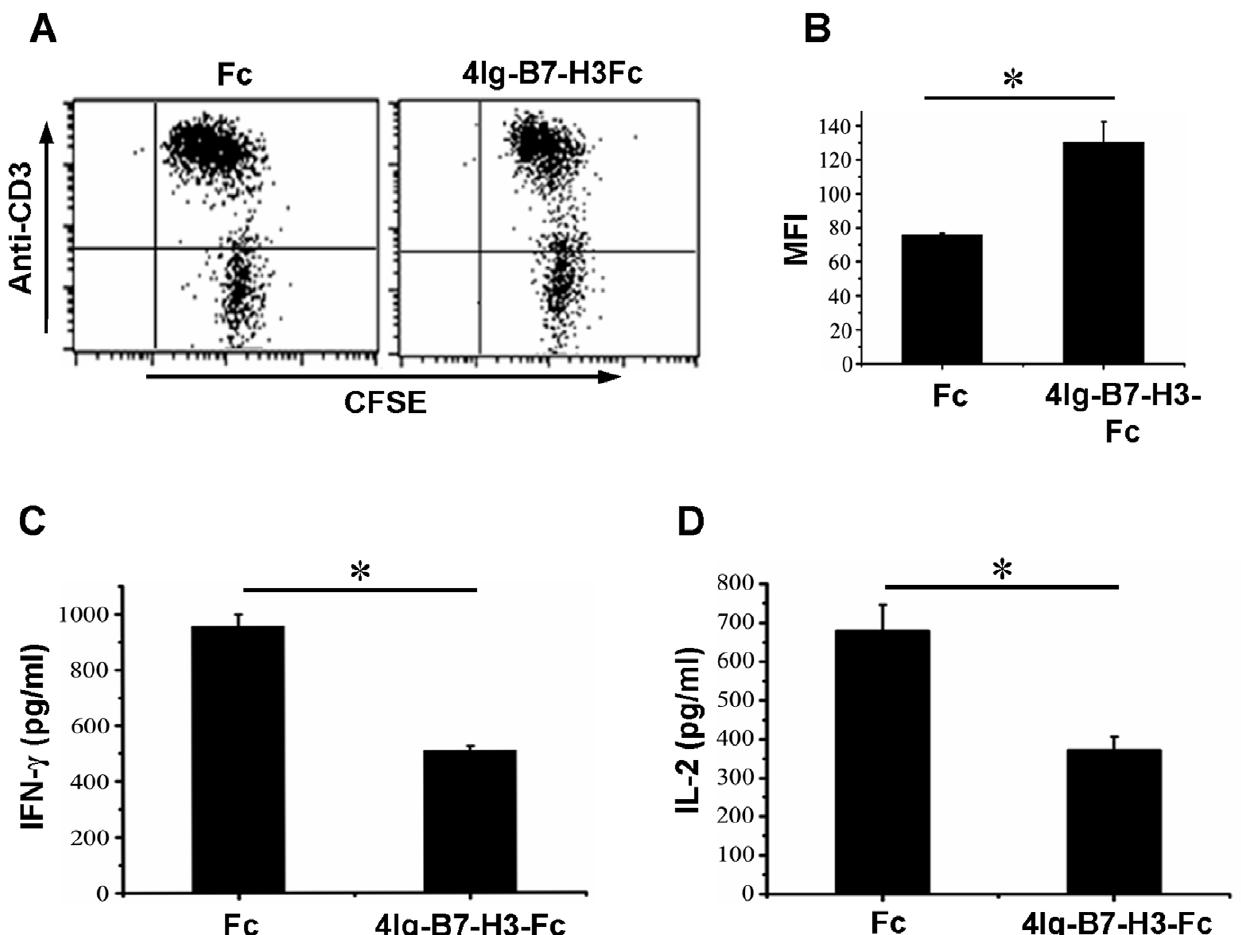
Figure 4. Porcine 4Ig-B7-H3 inhibited T cell functions. A, Freshly isolated porcine PBMCs were seeded to 96-well plate precoated with 1 m g/ml of anti-CD3 mAb plus either 10 m g/ml of 4Ig-B7-H3-Fc or Fc in 50 m l over night at 4 u C. After culturing for 72 hours, T cell proliferation in the presence of Fc (left plot) or 4Ig-B7-H3-Fc (right plot) was analyzed. The plots were from one representative experiment of three independent samples. B, Statistic analysis of mean fluorescence intensity (MFI) on T cells (mean 6 s.e.m). C and D, T cells purified from porcine PBMCs were seeded to the 96-well flat-bottomed plate precoated with 1 m g/ml of anti-CD3 mAb plus either 10 m g/ml 4Ig-B7-H3-Fc or Fc in 50 m l over night at 4 u C. After culturing for 72 hours, supernatants were harvested to quantify IFN- c (C) and IL-2 (D) concentration using ELISA kit. All data were from a representative of three independent experiments. * means P , 0.05.